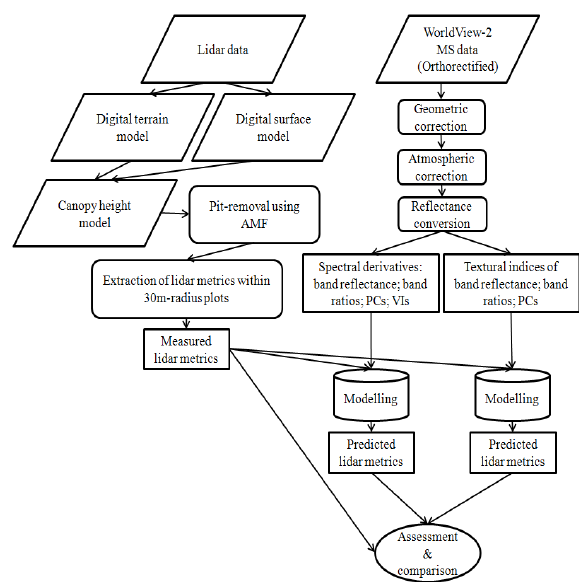
Figure 2. The flow chart of the methodology used in this